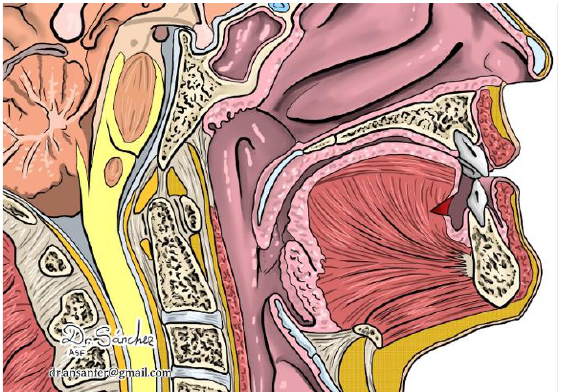
Figure 4. After frenotomy, the tongue takes a normal position.